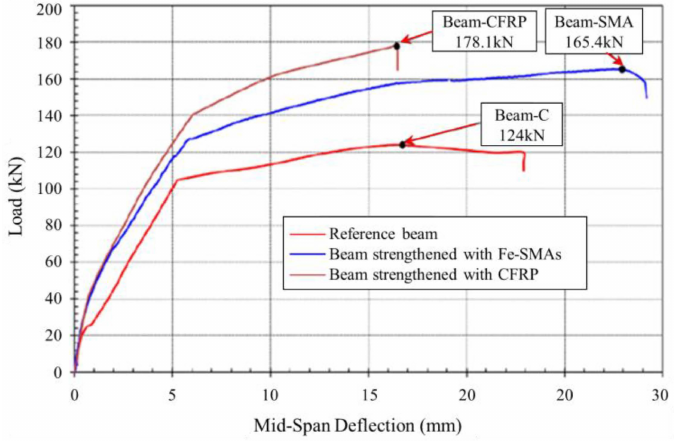
Figure 13. Load–deflection curves of beams